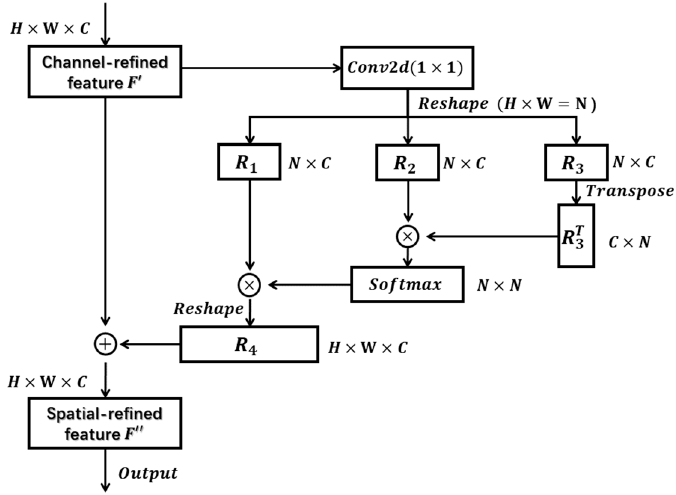
Figure 6. The structure of the spatial attention module is modified by the autocorrelation matrix